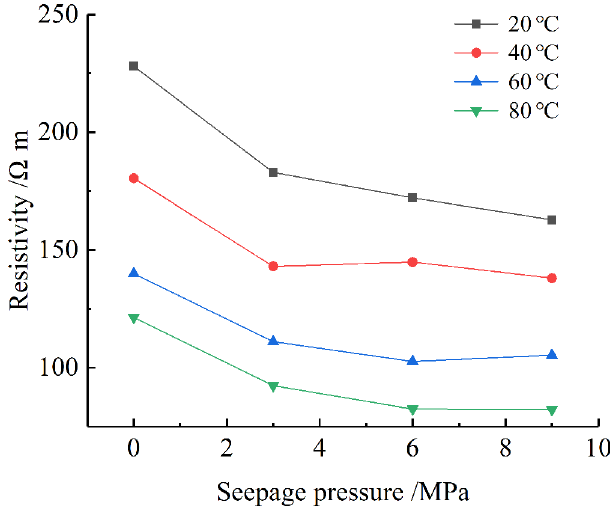
Figure 9. Photo of fractured granite specimen. (a) End of specimen. (b) Side of specimen. (c) Fracture surface. Figure 10. Variation curve of resistivity with seepage